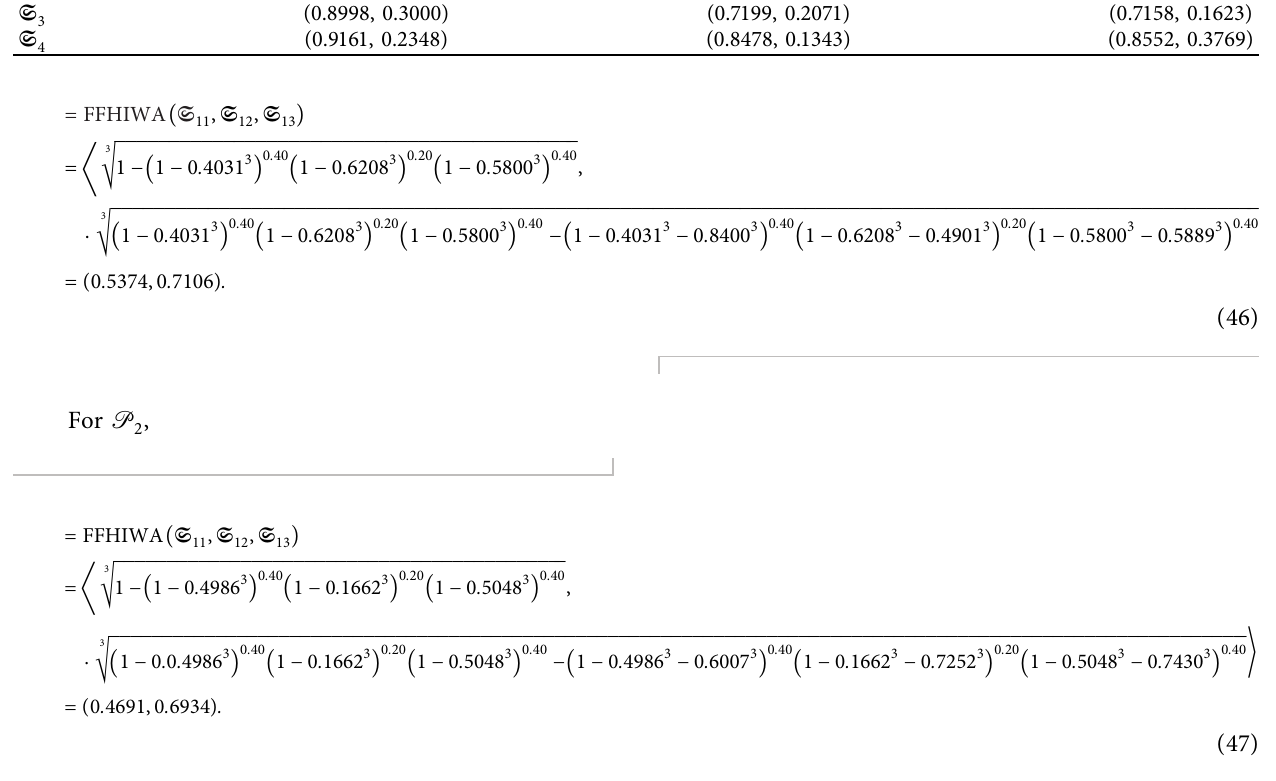
Table 4: Aggregated FF decision